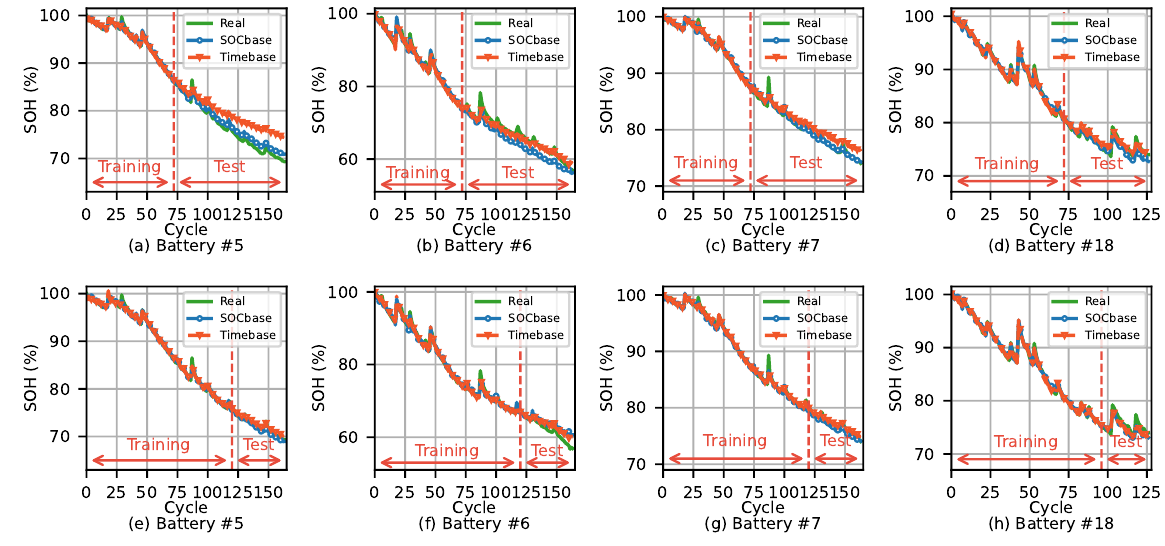
Figure 6. SOH estimation results using